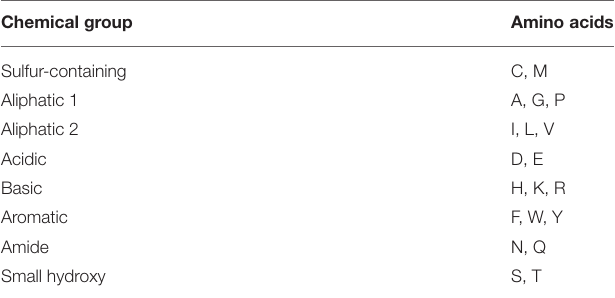
TABLE 2 | The chemical classes to which the 20 amino acids